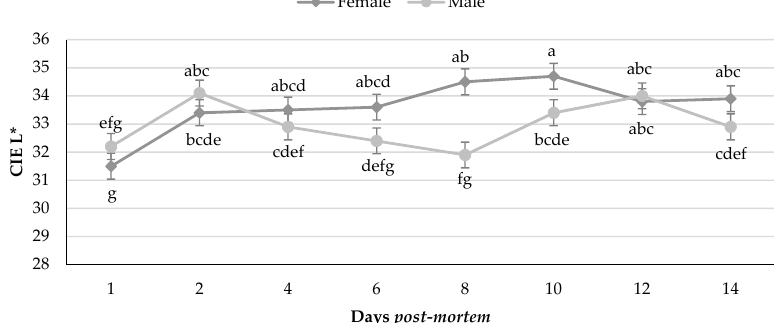
Figure 3. Effect of sex and ageing (days post-mortem ) on the L* (lightness) values of the surface color of impala longissimus thoracis et lumborum meat from females and males. a–g Means with different superscripts differ from one another ( p ≤ 0.05). Error bars represent the standard error of the means.